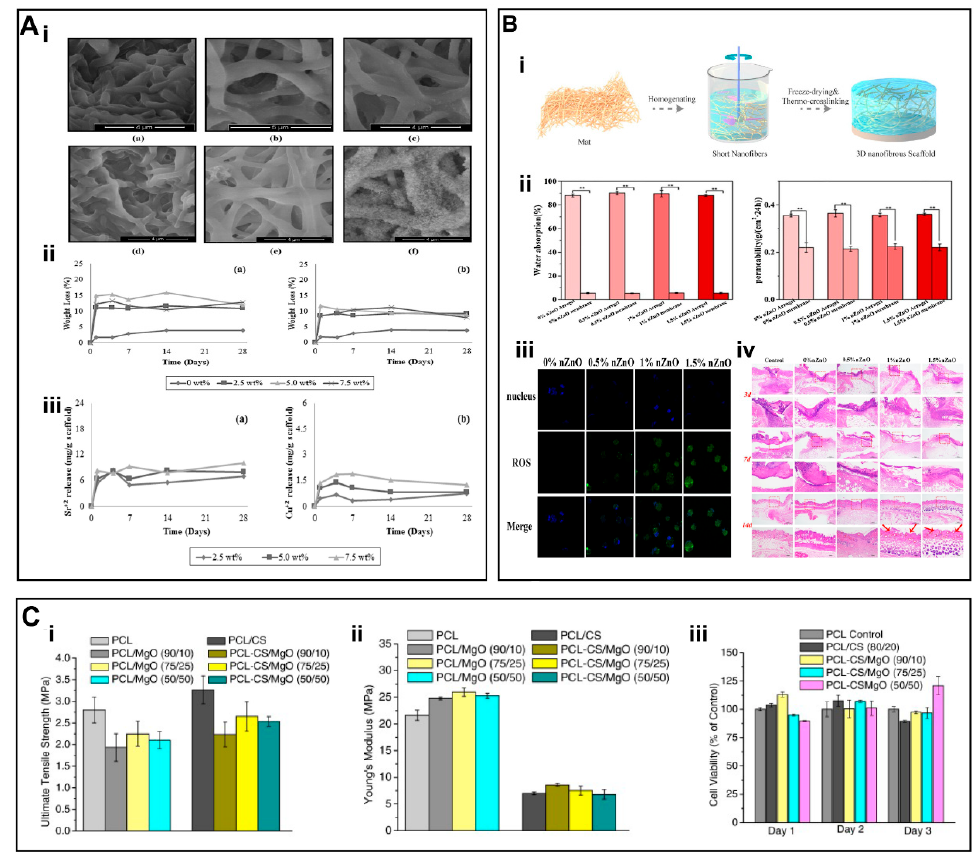
Figure 5. A . (i) SEM images of PCL/gelatin fiber mats containing Sr and Cu-doped BG after im- mersed in SBF. (ii–iii) Mass loss and ion release curves (a) Gt/PCL/Sr-BG and (b)